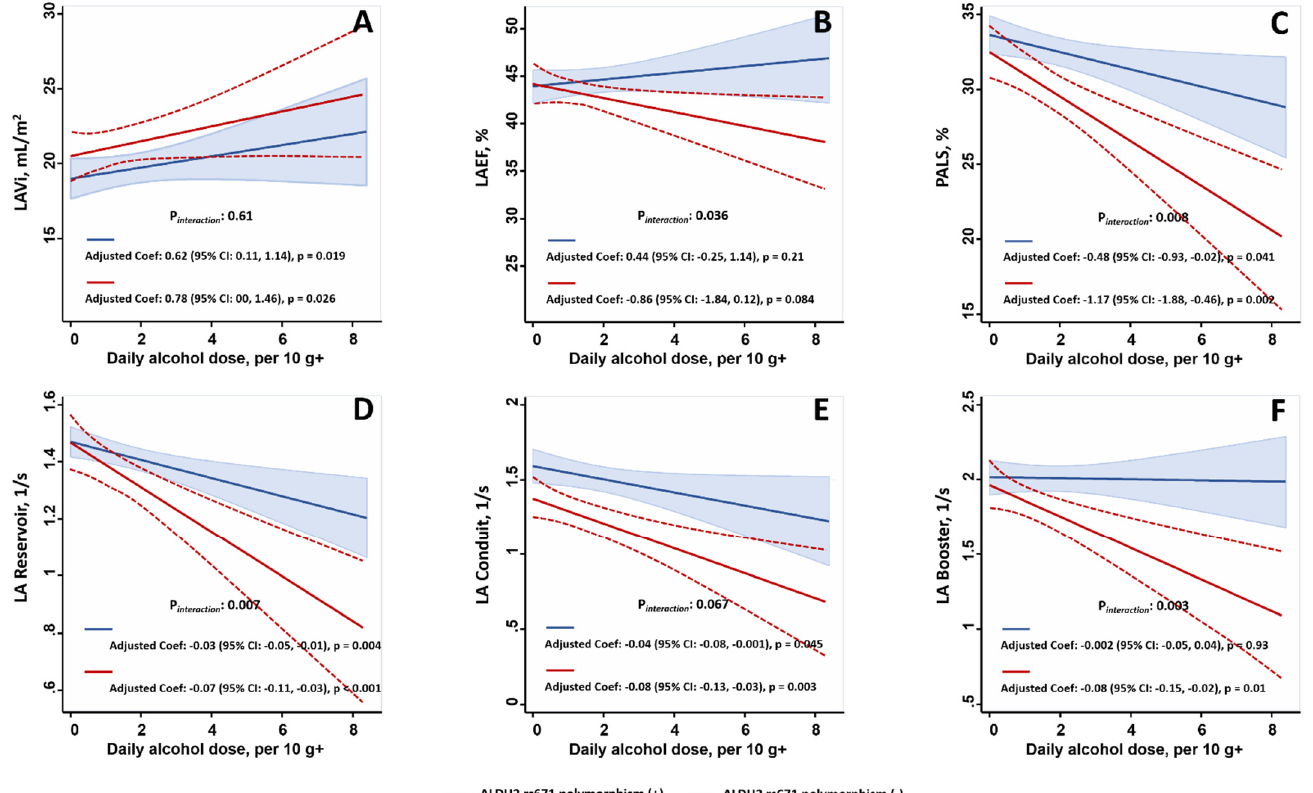
Figure 2. Linear regression models that were used in the present study, which demonstrate that ALDH2 polymorphism modified the association between daily alcohol intake (g/day) and worsened LA mechanical parameters (including LAVi ( A ), LAEF ( B ) and novel LA deformation markers ( C – F ) with steeper slopes for LAEF, PALS, and LA strain rates of the reservoir and booster pump functions (P interaction : <0.05). The models were subjected to adjustment for age, body mass index, renal function in terms of eGFR (as continuous variables), gender, medical histories of hypertension, diabetes, coronary artery disease, medications used for hyperlipidemia, and active smoking status (in contrast to non-smokers plus prior smokers) (all as binary variables). Dashed lines refer to 95% confidence interval.